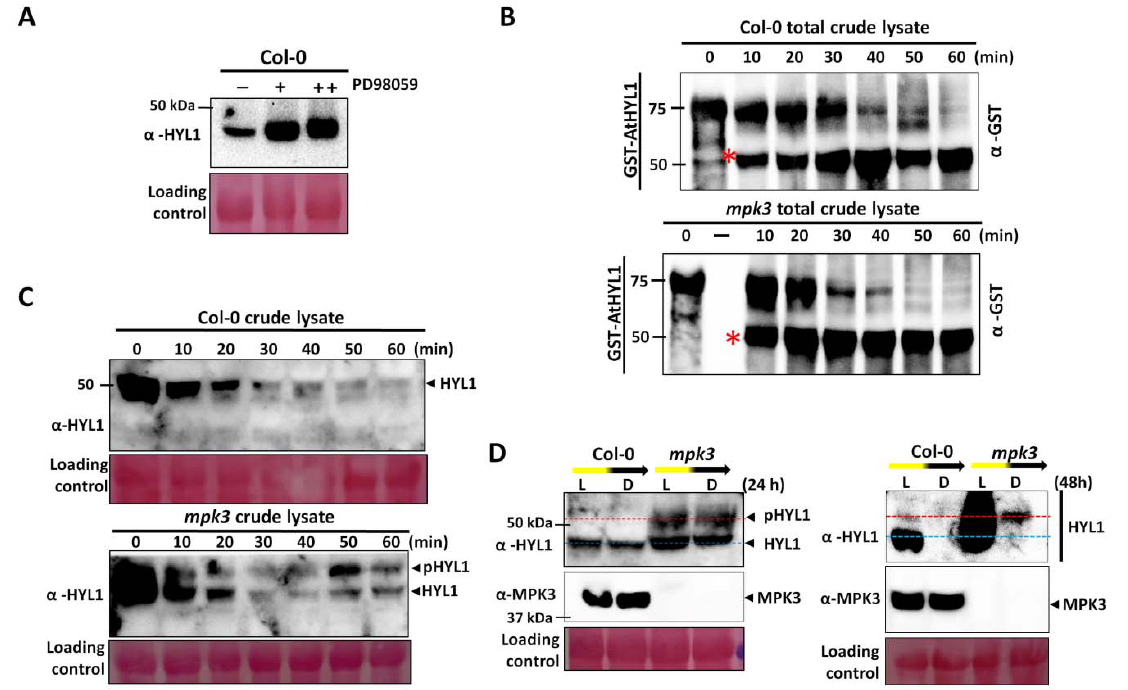
Figure 4. MPK3 promotes AtHYL1 protein degradation. ( A ) Col-0 seedlings (10 days old) were treated with or without (+/ − ) MAPK inhibitor (PD98059) overnight, and then total protein was used for HYL1 detection. ++ indicates double concentration of PD98059. ( B ) The cell-free degradation assay of the GST-HYL1 protein. Bacterially expressed and purified protein was incubated with the total protein extracted from Col-0 and mpk3 seedlings for the indicated times, and AtHYL1 protein was detected using anti-GST antibody. The asterisk (*) indicates the proteolytic cleaved product. ( C ) The stability of endogenous HYL1 was monitored by extracting the total protein from Col-0 and mpk3 seedlings and then incubating at room temperature for the indicated times. An anti-HYL1 antibody was used to detect the HYL1 protein. pHYL1 indicates the phosphorylated protein. ( D ) A Western blot showing the stability of AtHYL1 in Col-0 and mpk3 seedlings in response to light-to-dark transitions at 24 h and at 48 h. An anti-MPK3 antibody was used to detect the total MPK3 protein. All the above experiments were repeated five